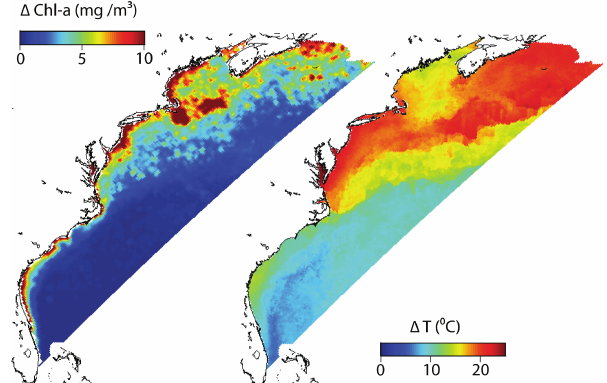
Fig. 1. Annual amplitude of surface chlorophyll concentration from the SeaWiFS satellite (left) and of sea surface temperature from AVHRR (right), calculated as maximum monthly mean minus min- imum monthly mean, for the Northeastern North Atlantic shelves and adjacent deep ocean. The annual amplitude in chlorophyll is largest in coastal waters of the Middle Atlantic Bight (MAB), on Georges Bank, the Gulf of Maine and the Scotian Shelf. The annual amplitude in sea surface temperature is largest in coastal regions of the MAB and on the Scotian Shelf; tidal mixing in the Bay of Fundy (northern Gulf of Maine) and on Georges Bank lead to com- paratively smaller seasonal temperature differences